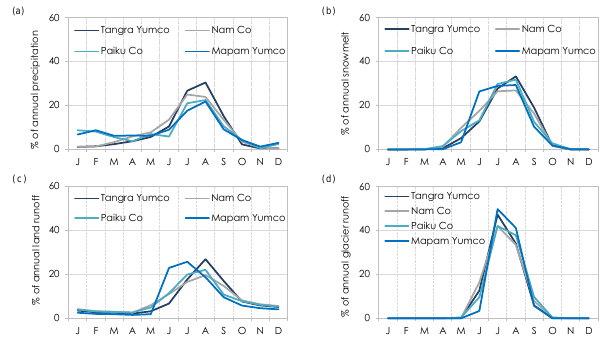
Figure 5. (a) Monthly percentage of annual precipitation, (b) snowmelt from non-glacierized land areas, (c) runoff from non- glacierized land areas, and (d) glacier runoff for the four studied basins.